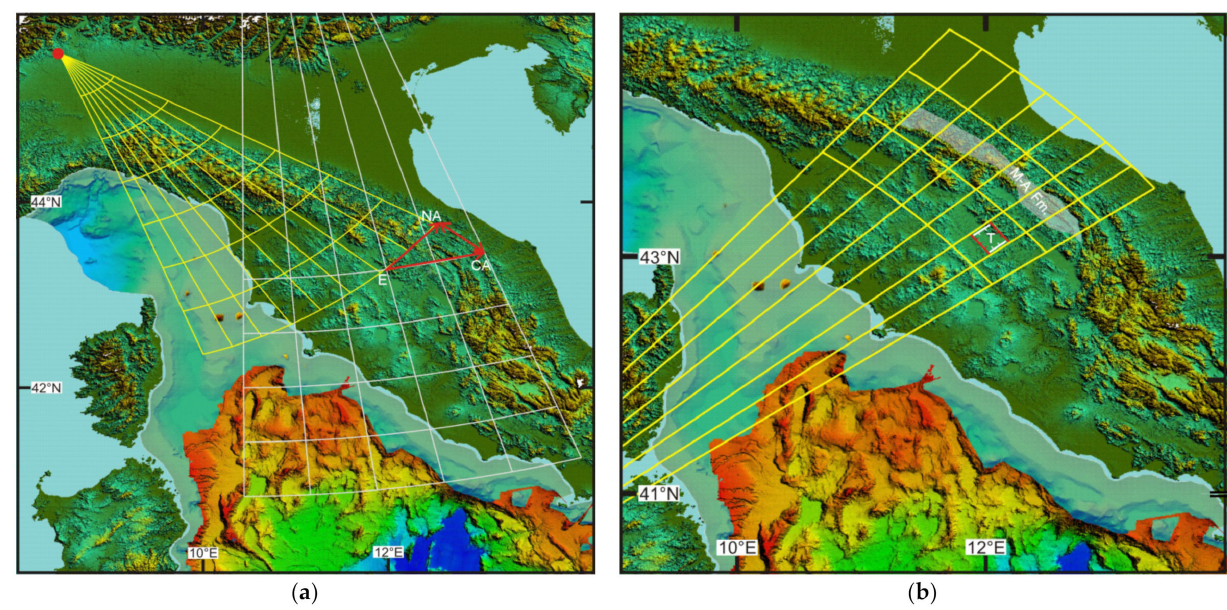
Figure 14. ( a ) Interaction between northern ( yellow grid ) and central ( white grid ) sectors. Red arrows are velocity vectors of the relative motion between the two sectors. E: Europe, NA: Northern Apennine, CA: Central Apennine. ( b ) Comparison between morpho-structures and the Stage pole grid valid from 5 Ma to present, between Northern Apennine and Central Apennine sectors. T: Trasimeno Lake, M-A Fm: Marnoso-Arenacea Formation. The Euler pole has coordinates: 38.95 ◦ − 5.61 ◦ .